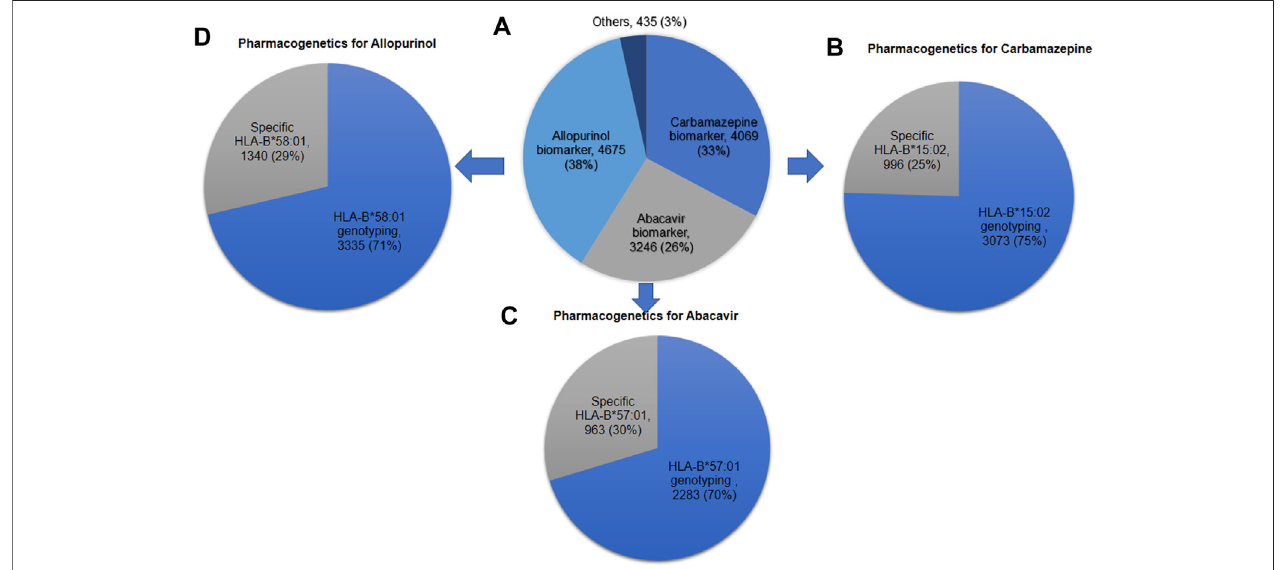
FIGURE 4 | Number of HLA-B pharmacogenetic testing requested for Thai patients to prevent severe cutaneous adverse drug reactions over 10 years during 2011 – 2020 (A) HLA-B pharmacogenetictestingforalldrugs(N=12,425); (B) Pharmacogenetictestingforcarbamazepine(N=4,069); (C) Pharmacogenetictestingfor abacavir (N = 3,246); (D) Pharmacogenetic testing for allopurinol (N = 4,675).